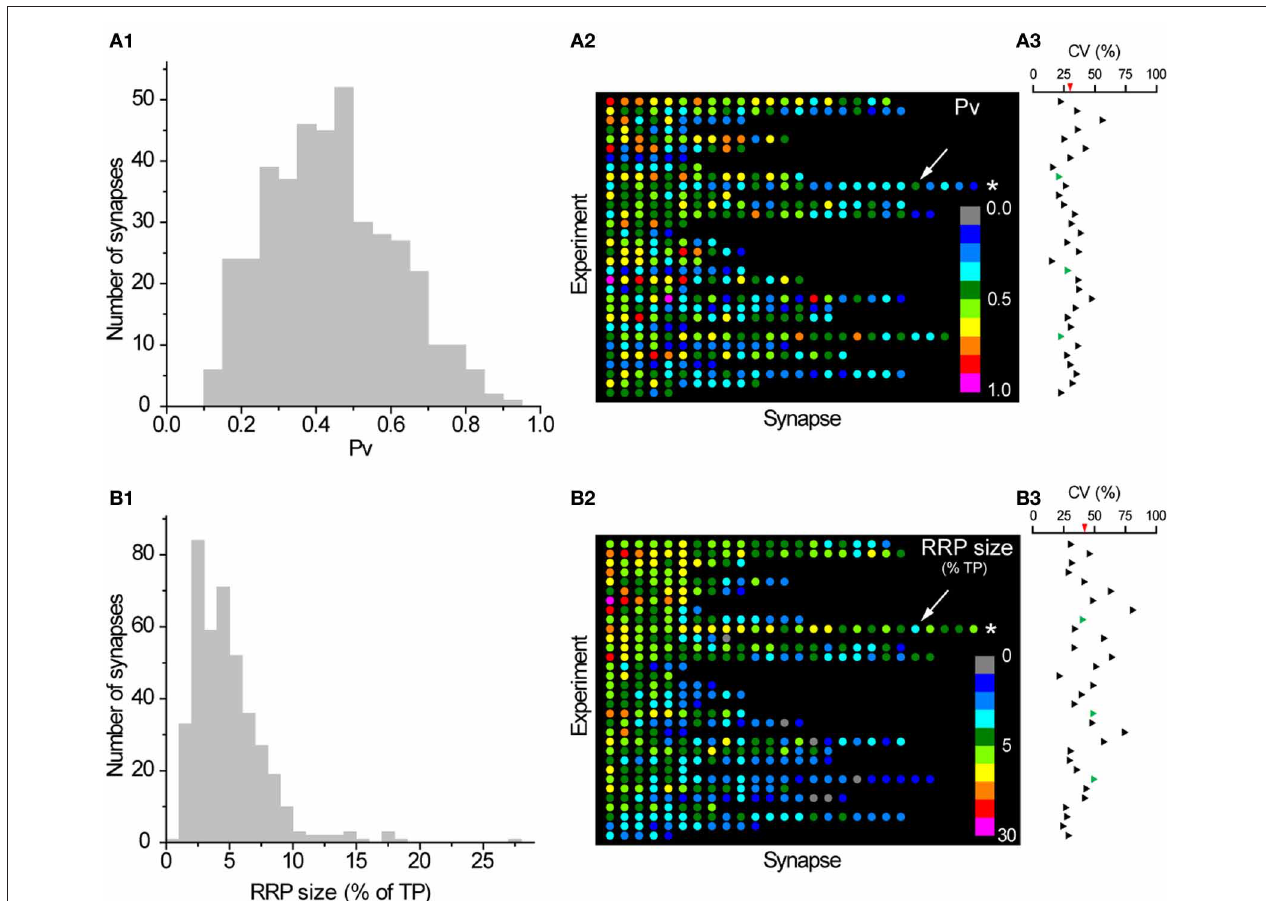
FIGURE 2 | Large variation in Pv and RRP size between individual synapses. (A1) Histogram of Pv across synapses (a synapse with 1 . 1 ± 0 . 2 was excluded for convenience of presentation). (A2) Color map of Pv values in all synapses included in our analysis. Each row in this plot represents a single experiment and each dot within that row a single synapse from that experiment. Synapses are colored according to their Pv with cold colors representing low Pv values and warm colors representing high Pv values. The inset shows the Pv color scale. Synapses within each experiment are ranked according to their average response to a single AP (as % of TP) from left (highest) to right (lowest). Experiments are ordered according to their average synaptic response to a single AP from top (highest) to bottom